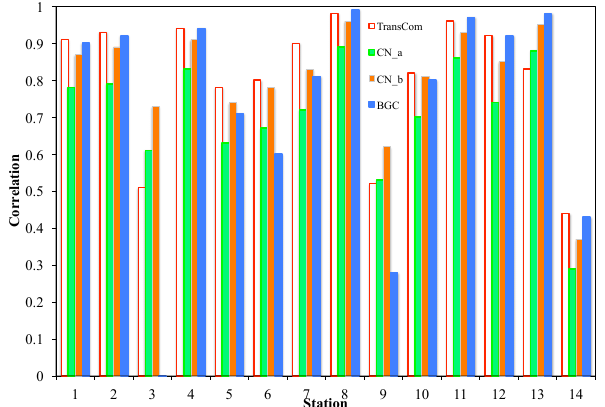
Figure 13. Comparison of correlations between TransCom, CN_a, CN_b, BGC, and observations (same as in Fig. 12). The station numbers correspond to those in Table